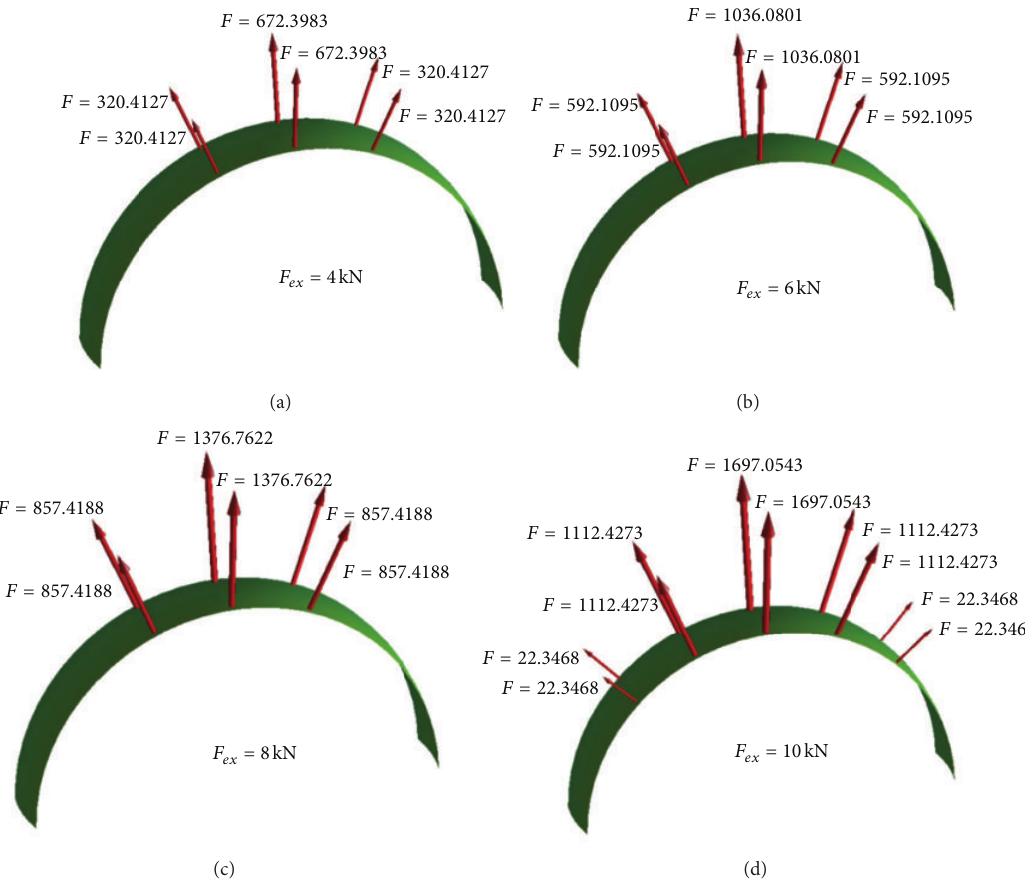
Figure 6: Contact forces of the rolling elements in case of different radial loads. The shaded surface represents the spherical surface of the outer race.